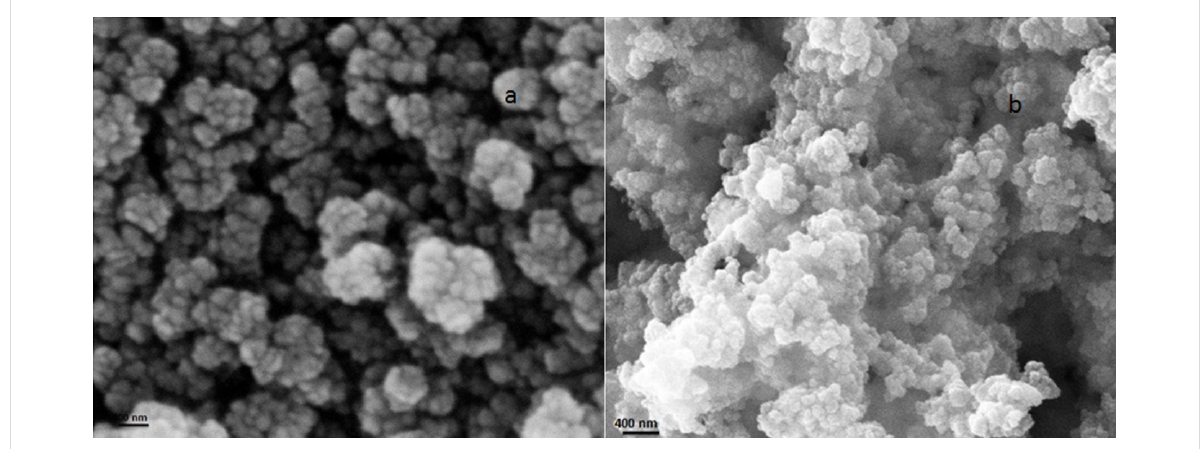
Figure 3: SEM images of Ta 2 O 5 nanoparticles obtained from (a) Ta(OEt) 4 (OOCCHCl 2 ) and (b) Ta(O n -Bu) 4 (OOCCHCl 2 ).